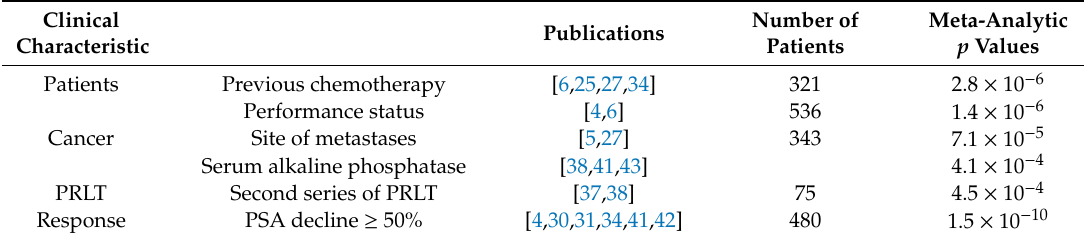
Table 2. Clinical characteristics and prediction of